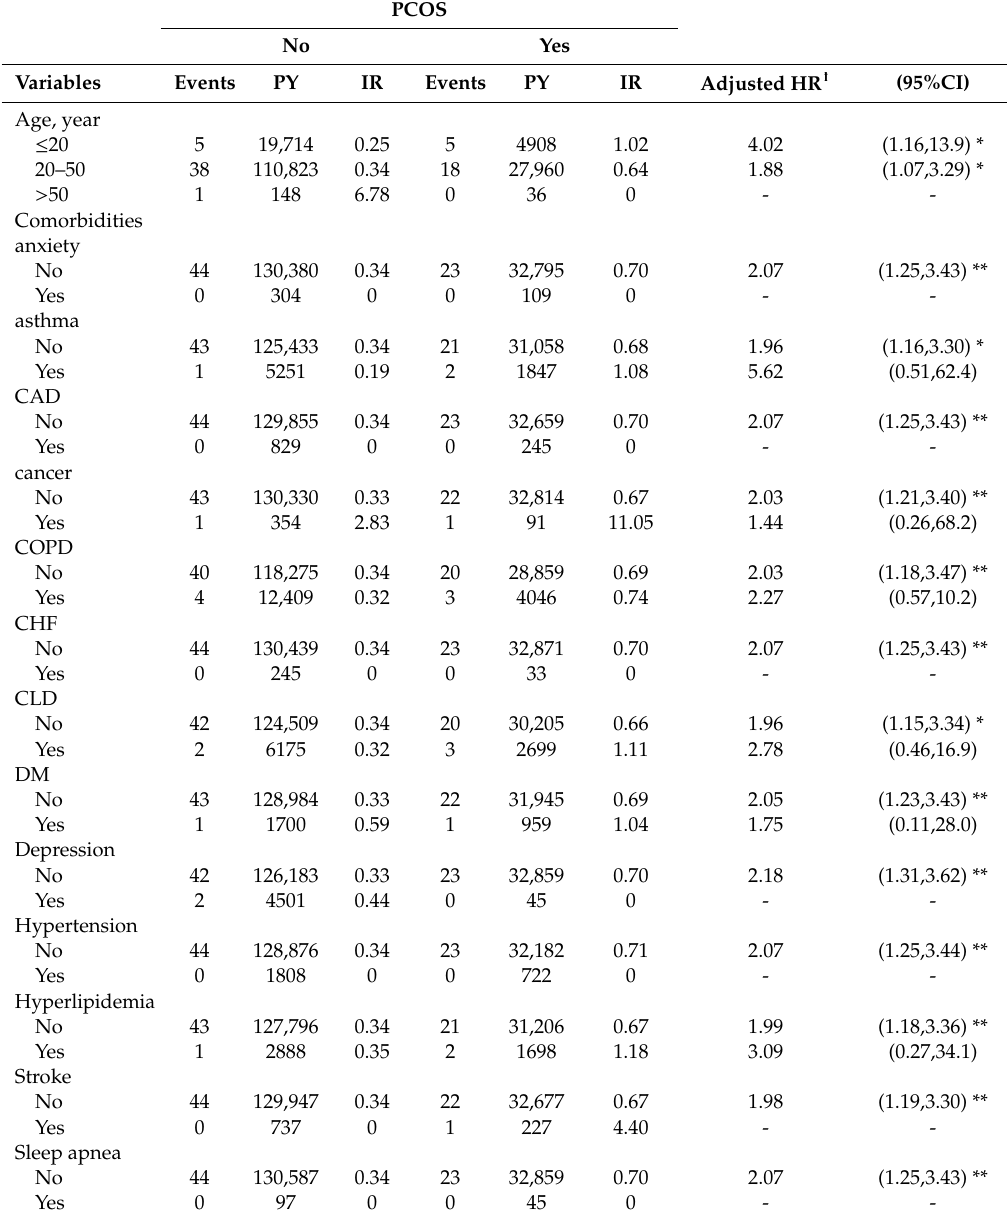
Table 3. Association of PCOS and psoriasis at di ff erent stratification levels. Figure 1. Cumulative incidence of psoriasis for patients with and without PCOS. Table 2. Incidence rates and hazard ratios of psoriasis.